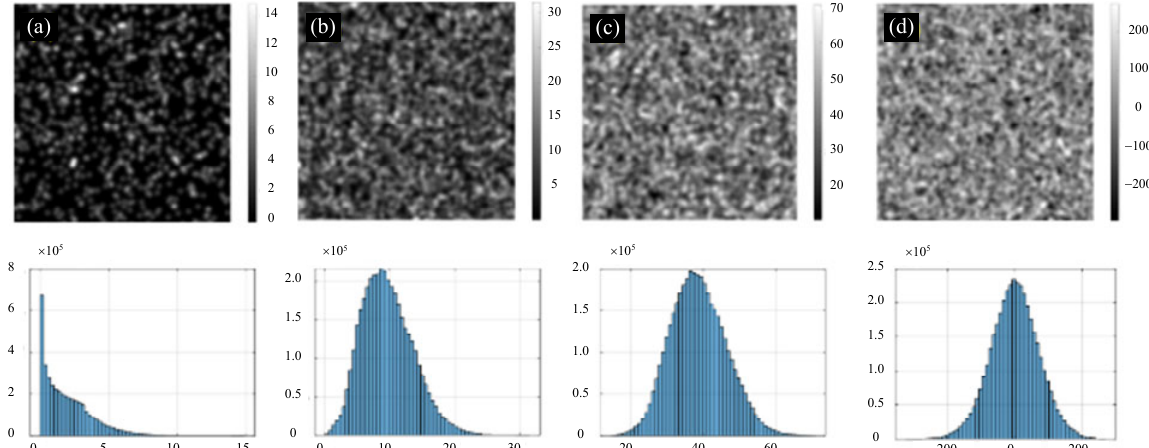
200 0 –200 Fig. 4 Evolution of phasemasks with the number of Gaussian bumps with a height of  and a radius  =60  m. Within a 2  2 mm 2 square area, 10 3 , 5  10 3 , and 2  10 4 Gaussian phase pinholes are randomly distributed in the upper row of (a–c), respectively. The colorbars denote phase value range of generated phasemasks accordingly. (d) A conventional phasemask generated under the constraint at  =10  m and  =60  m, corresponding to a Gaussian filter in frequency domain. As the phasemask grows maturely with a nearly symmetric histogram, it has the same appearance and statistical distribution as the conventional one except for the particular phase amplitude, which can be adjusted by adding 2 n  , n is an integer. By changing the height and/or number density of the phase pinholes, the phase amplitude and distribution of the generated phasemask can be altered. The vertical axis of the histogram denotes the number of pixels at each phase value.